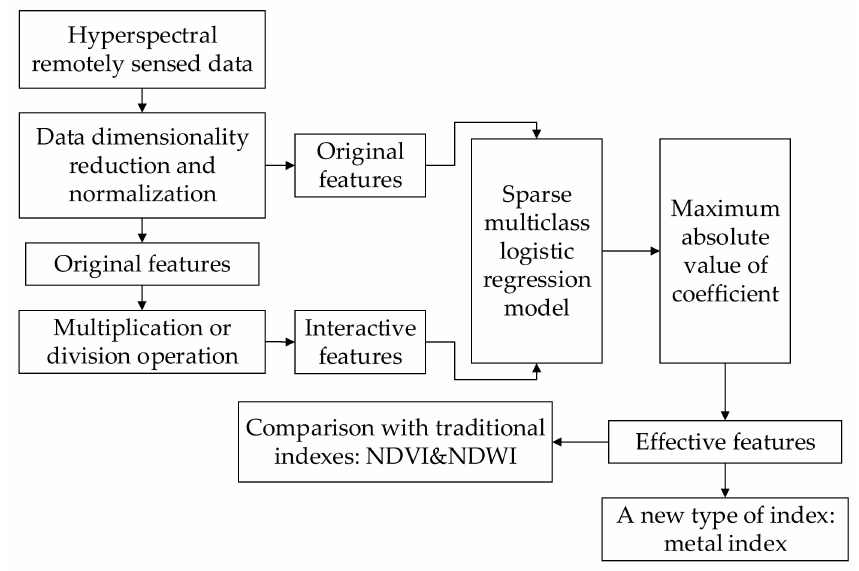
Figure 1. Technique